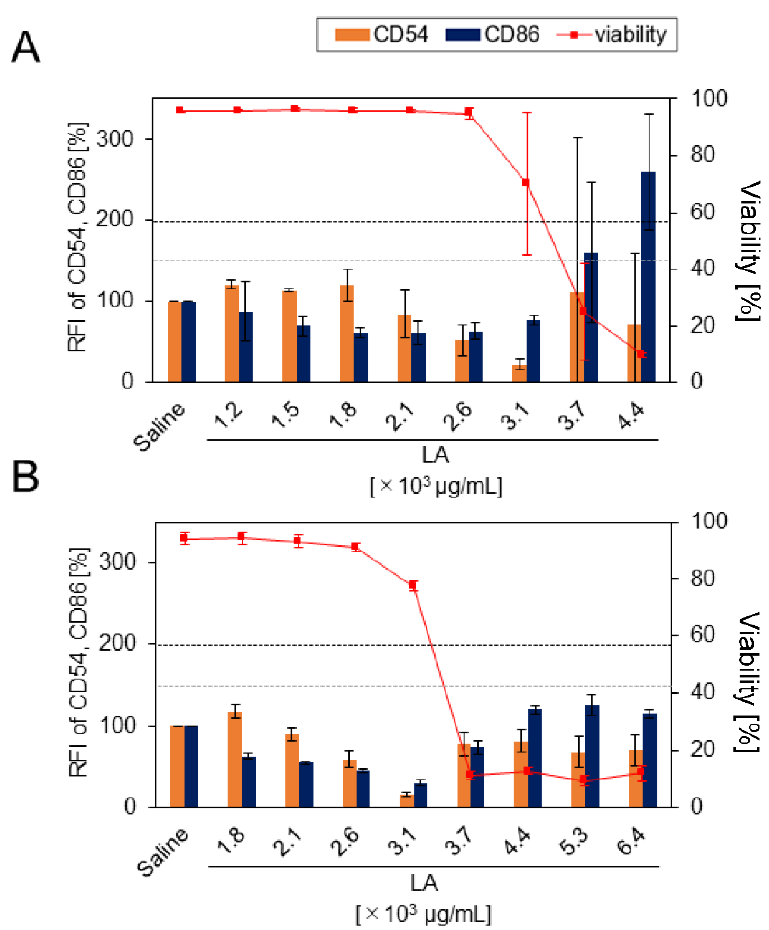
Figure 3. CD54 and CD86 expression induced by LA on THP-1 cells in monocultured ( A ) and co- cultured with keratinized NHEK cells ( B ). LA solution at eight concentrations prepared based on the CV75 determined for each exposure route was directly exposed to THP-1 cells ( A ), on the other hand, was applied on the surface of keratinized NHEK cells in cell culture insert ( B ). After 24 h of incubation, the expression of CD54 and CD86 and cell viability were analyzed using flow cytometry. Data are shown as relative fluorescence intensity (RFI, % of control). Mean values of RFI ± SD for three individual experiments are shown. The black and gray dashed lines visually indicate the positive criteria for skin sensitization in h-CLAT for CD54 and CD86, respectively (CD54 ≥ 200%, CD86 ≥ 150%).